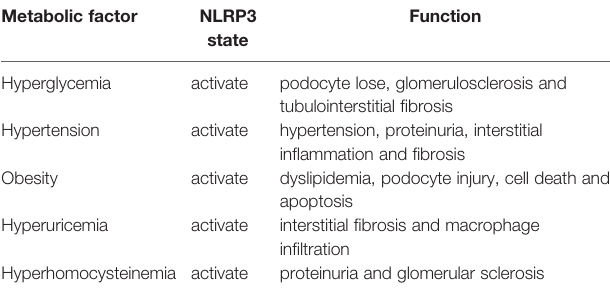
TABLE 1 | The role of NLRP3 in fl ammasome in the kidney under different metabolic disorders. Metabolic